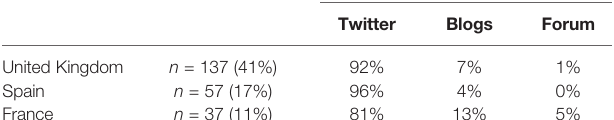
TABLE 1 | Origin of conversations by region. Country/region Share of total posts (%) N =